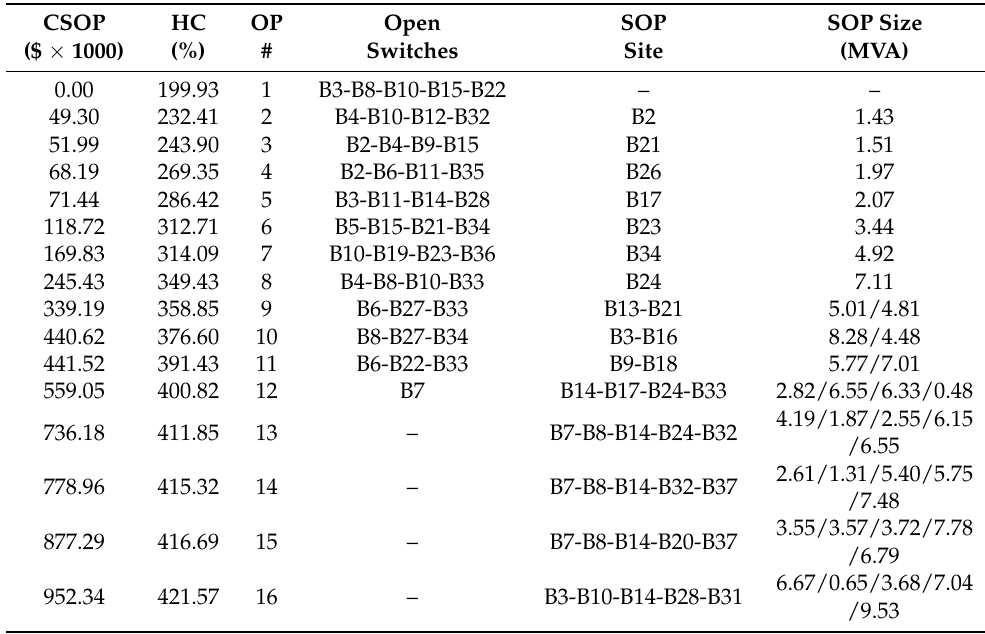
Table 7. Nondominated solutions from MOAIS, Case